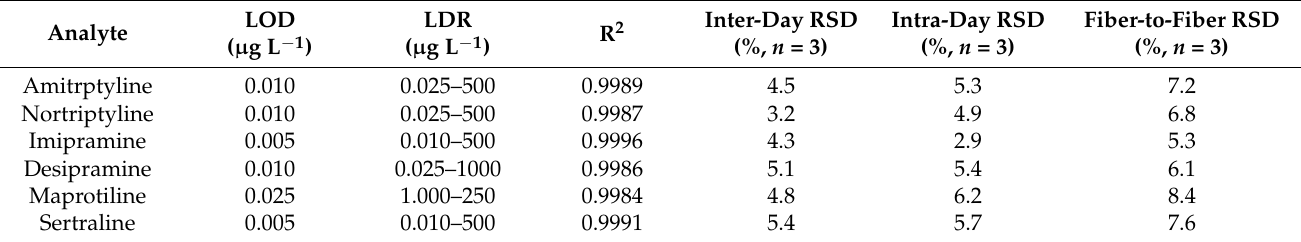
Table 1. Figures of merit for proposed on-chip EM-SPME-GC–MS for TCAs from aquatic samples